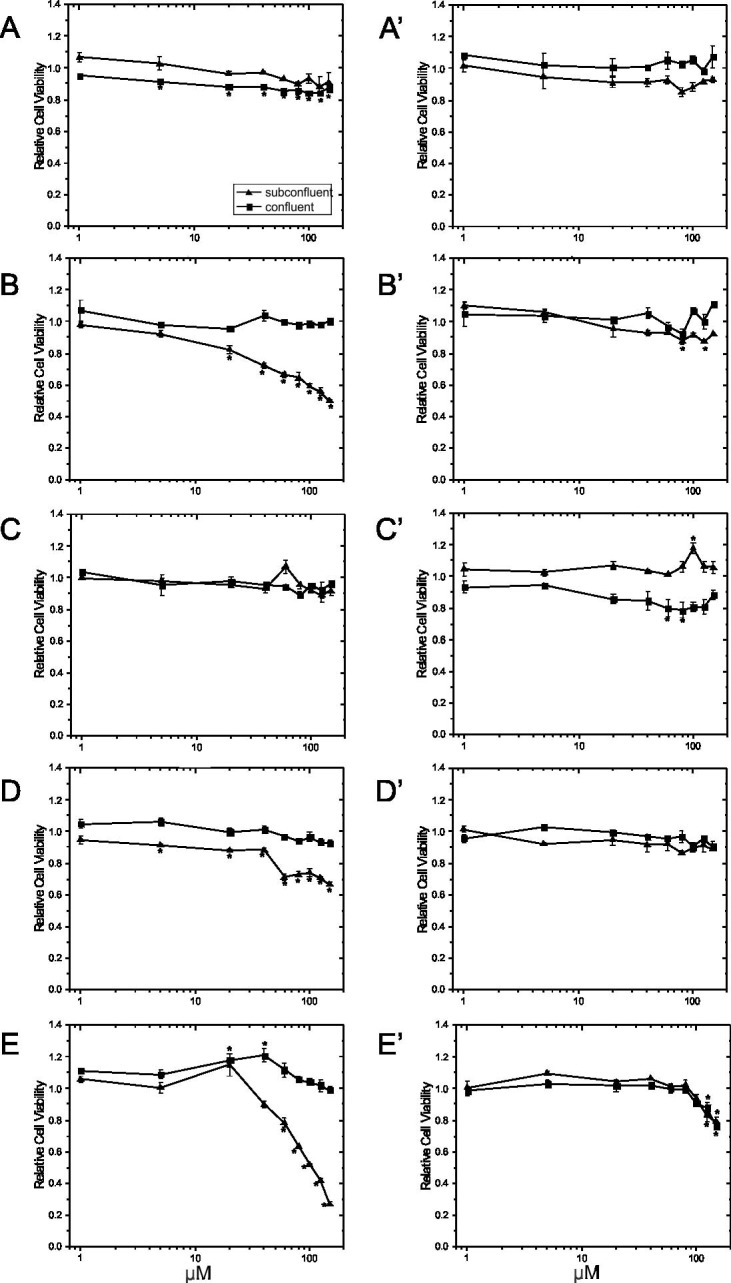
Effect of ECM substrate and growth state on viability of EA.hy926 cells in presence of PUFAs.EA.hy926 endothelial cells were seeded on plastic culture plates at 9000 cells/cm2 in the absence (Panel A-E) or presence of Matrigel (Panel A’-E’). Growing cells (day 4) or confluent cells (day 8) were treated with different PUFAs [LA (Panel A, A’), AA (Panel B, B’), ALA (Panel C, C’), EPA (Panel D, D’) and DHA (Panel E, E’)] at final concentrations of 1, 5, 20, 40, 60, 80, 100, 125 and 150 μM for 24 hours, at which point, cell viability was assessed using the CCK-8 assay. Data are normalized with vehicle control values and plotted as means ± SEM (n = 3). *Significantly different (p <0.05) from the vehicle control for the respective growth state.